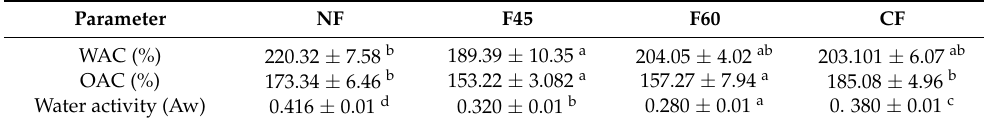
Table 4. Techno-Functional properties of Maya nut flours.